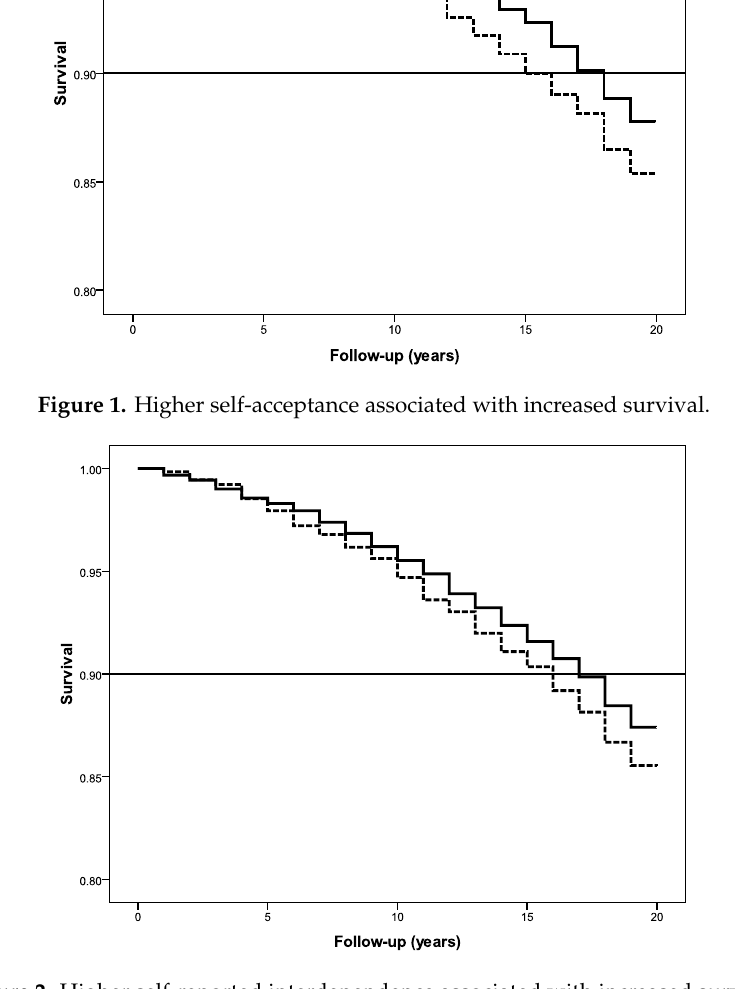
Figure 2. Higher self-reported interdependence associated with increased survival.